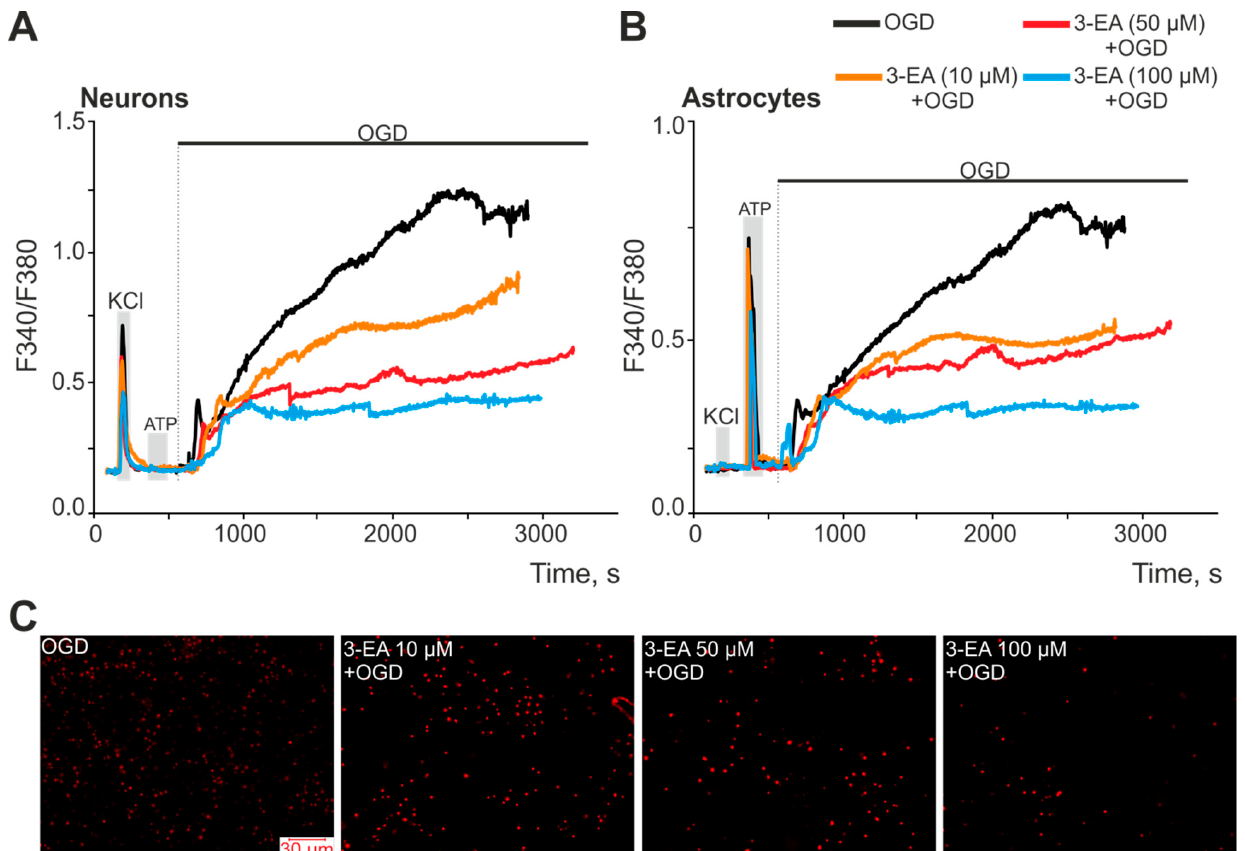
Figure 4. An effect of 24 h preincubation of cerebral cortex cells with various concentrations of 3-EA on the increase in [Ca2+]i during 40 min of OGD: an average Ca 2+ signals of neurons ( A ) and astrocytes ( B ) of the cells during OGD. Short-term (30 s) applications of KCl (35 mM) and ATP (10 µM) were performed to detect neurons and astrocytes, respectively. ( C ) Staining of the cell culture with the propidium iodide fluorescent probe, reflecting necrotic death after 40 min of OGD. The experiments were performed in triplicate on three cell cultures of different passages.